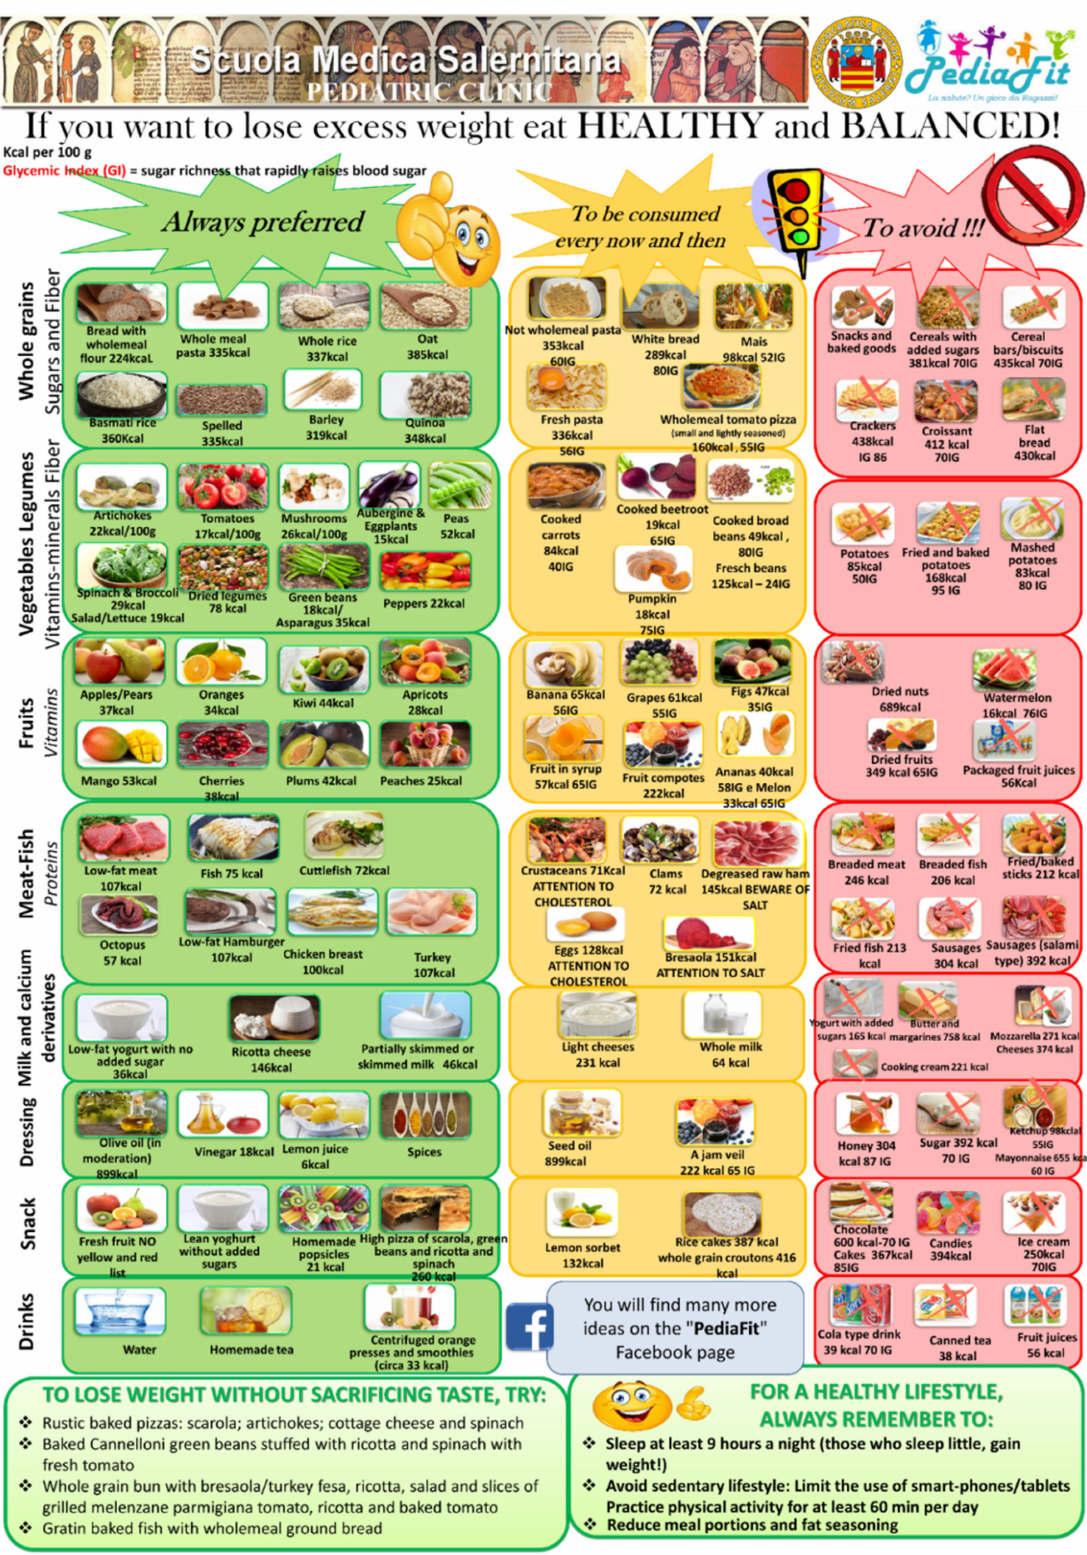
Figure A1. Food traffic light - English